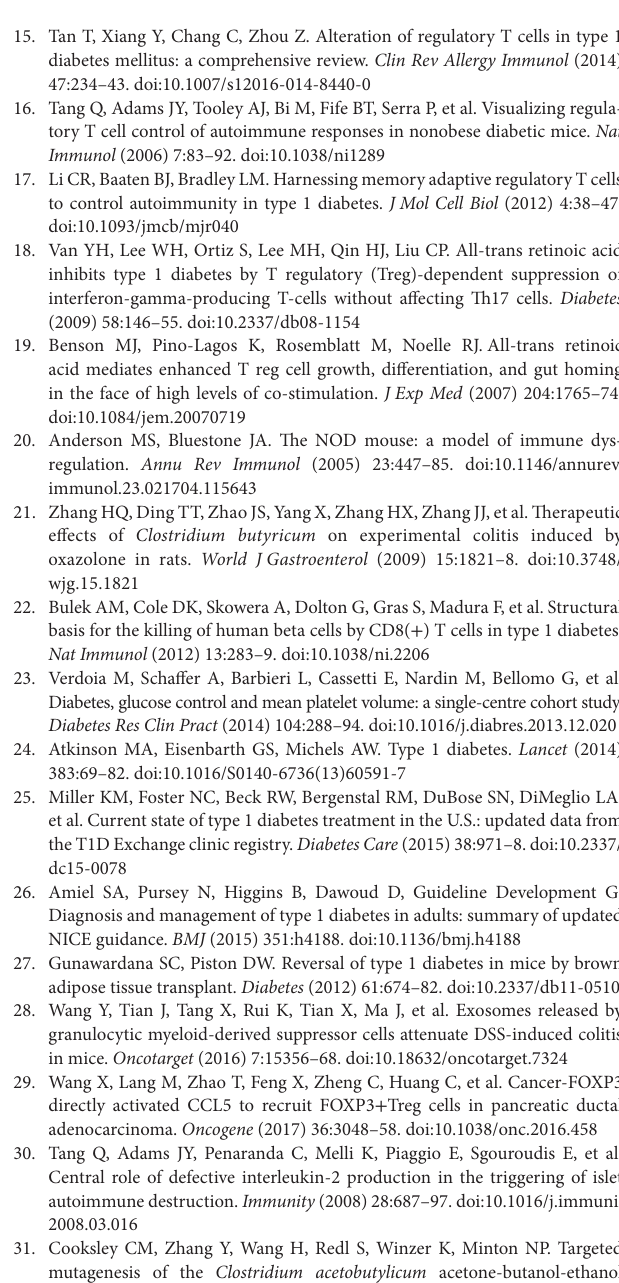
TaBle s1 | Information of antibody for FACS. TaBle s2 | Primer sequences used in this study for microbial abundance. TaBle s3 | Information of antibody for FACS for the experiment of regulatory T cells migration. TaBle s4 | Information of antibody for FACS for the experiments of CD45 + CD11c +